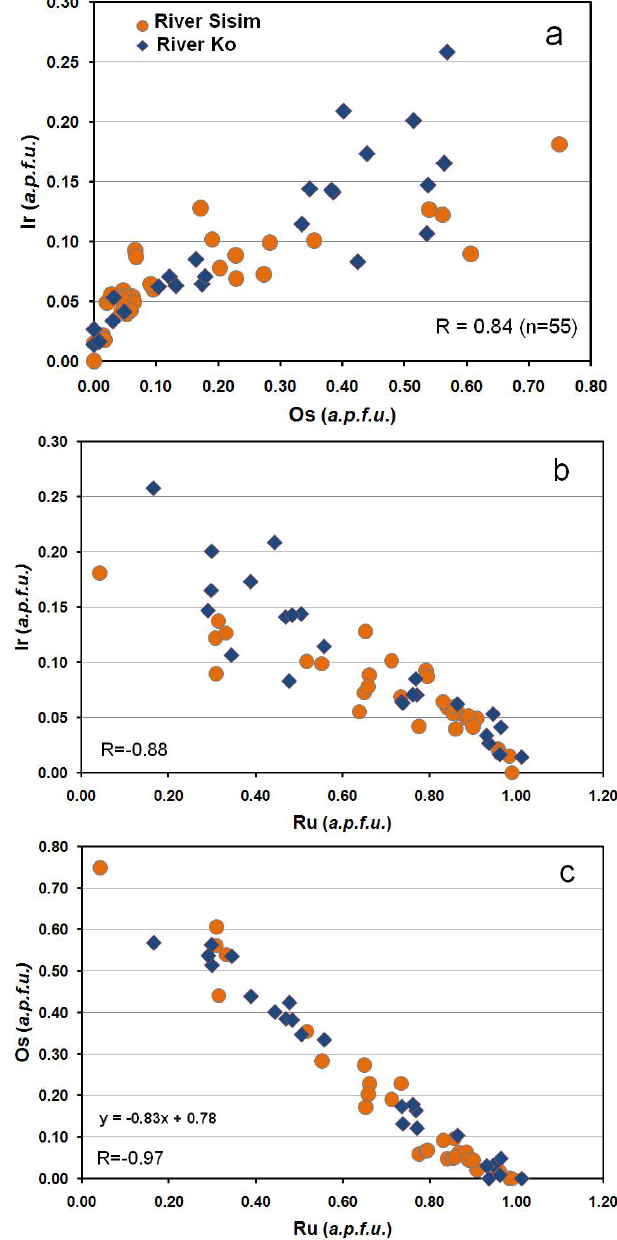
Figure 6. Correlations of Ir and Os ( a ); Ir and Ru ( b ); and Os and Ru ( c ) observed in compositions of members of the laurite–erlichmanite series, which occur as inclusions in placer grains of Os–Ir–(Ru) alloys from the Sisim River system (this study), compared with laurite–erlichmanite grains from the River Ko placer [3]. The equation of linear regression and values of the correlation coefficient (R) are based on a total of 55 data-points (this study).